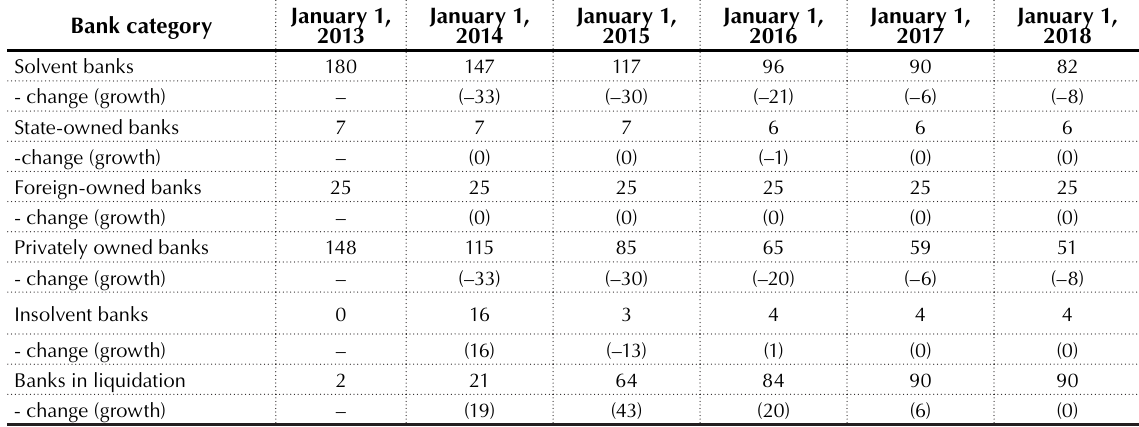
Table 1. Dynamics of structural changes in the banking sector of Ukraine in 2012–2017 Source: Calculated by the authors based on the NBU statistical